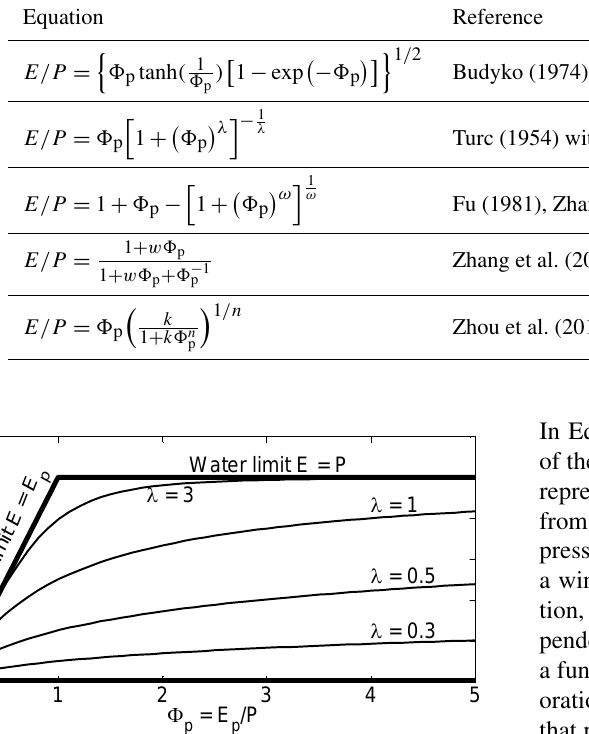
Table 1. Different expressions of the Budyko functions as a function of the aridity index (cid:56) p . Equation Reference